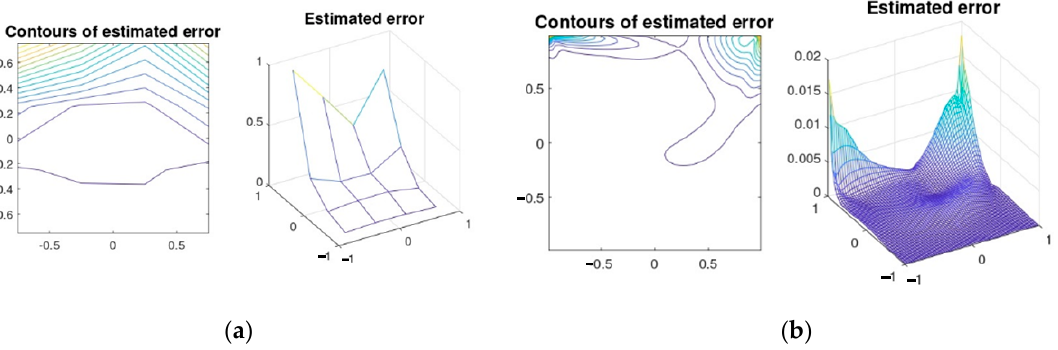
Figure 7. Error associated with a 16 × 16 and a 256 × 256 square grid, Q 1 – P 0 approximation. ( a ) 16 × 16 elements; ( b ) 256 × 256 elements.